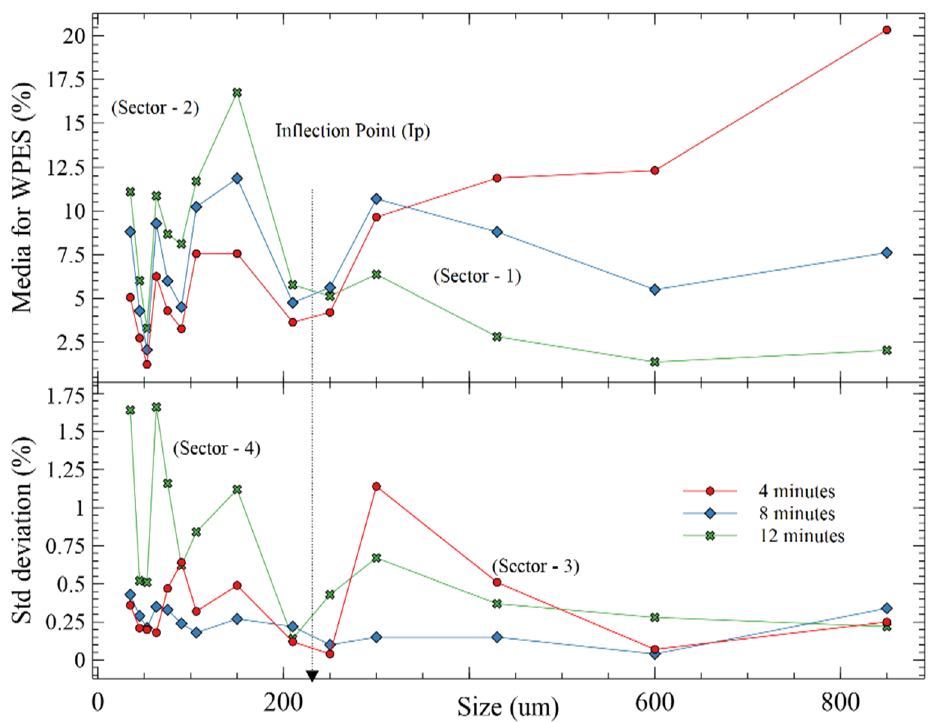
Figure 4. GA for comparative grinding time with 95% confidence. WPES are shown ( above ) and standard deviations are shown ( below ).